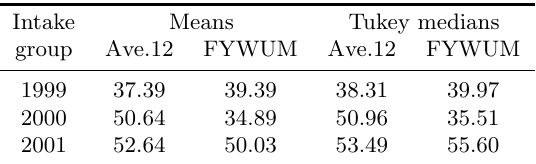
Table 4: Means and Tukey medians of Science and FYWUM for 1999, 2000 and